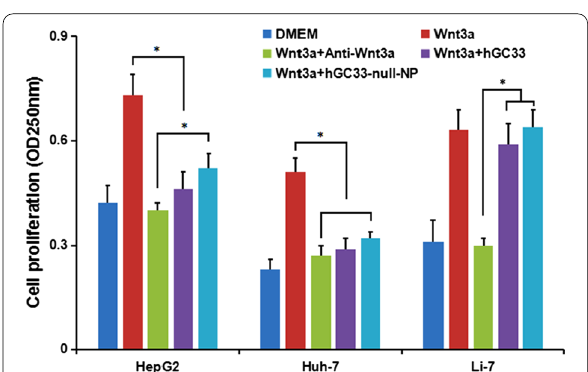
Fig. 6 GPC3-activated Wnt signal transduction in HCC. Fifty percent Wnt3a DMEM medium was added with anti-wnt3a antibody, hGC33, or hGC33-null-NP. HepG2 (GPC3 ++ ), Huh-7 (GPC3 + ) and Li-7 (GPC3 − ) cells were co-incubated for 48 h, and cell proliferation was measured by MTT assay. The data were expressed as mean